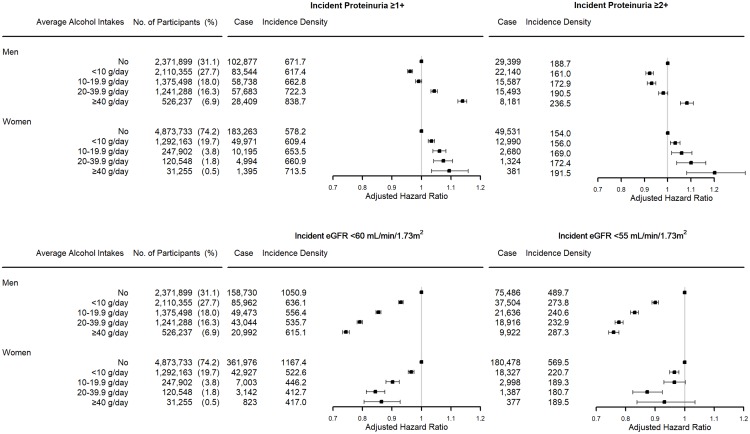
The association between alcohol intake and the risk of incident proteinuria and low estimated glomerular filtration rate (eGFR).Incident proteinuria was defined as ≥1+ or 2+ spot urine dipstick test for proteinuria in the participants who showed negative dipstick test at baseline. Incident low eGFR was defined as a decrease in eGFR <60 or 55 mL/min per 1.73 m2 in the participants who had eGFR ≥60 mL/min per 1.73 m2 at baseline. eGFR was calculated with the Chronic Kidney Disease Epidemiology Collaboration equation based on serum creatinine level. The risk was analyzed with an extended Cox model with alcohol intake level as a time-varying determinant, adjusted for baseline characteristics; age, sex, body mass index, systolic blood pressure, fasting serum glucose, serum high-density lipoprotein cholesterol and triglycerides levels, history of diabetes and hypertension medication, regular exercise, smoking status, and eGFR for incident proteinuria. Dots and error bars represent the adjusted hazard ratio and 95% confidence interval, respectively.